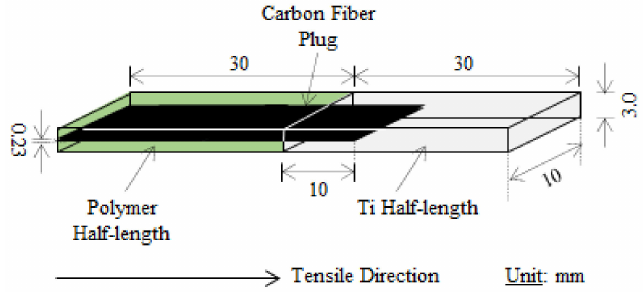
Figure 1. Schematic illustration of CF plug joint specimen [10,11,46].